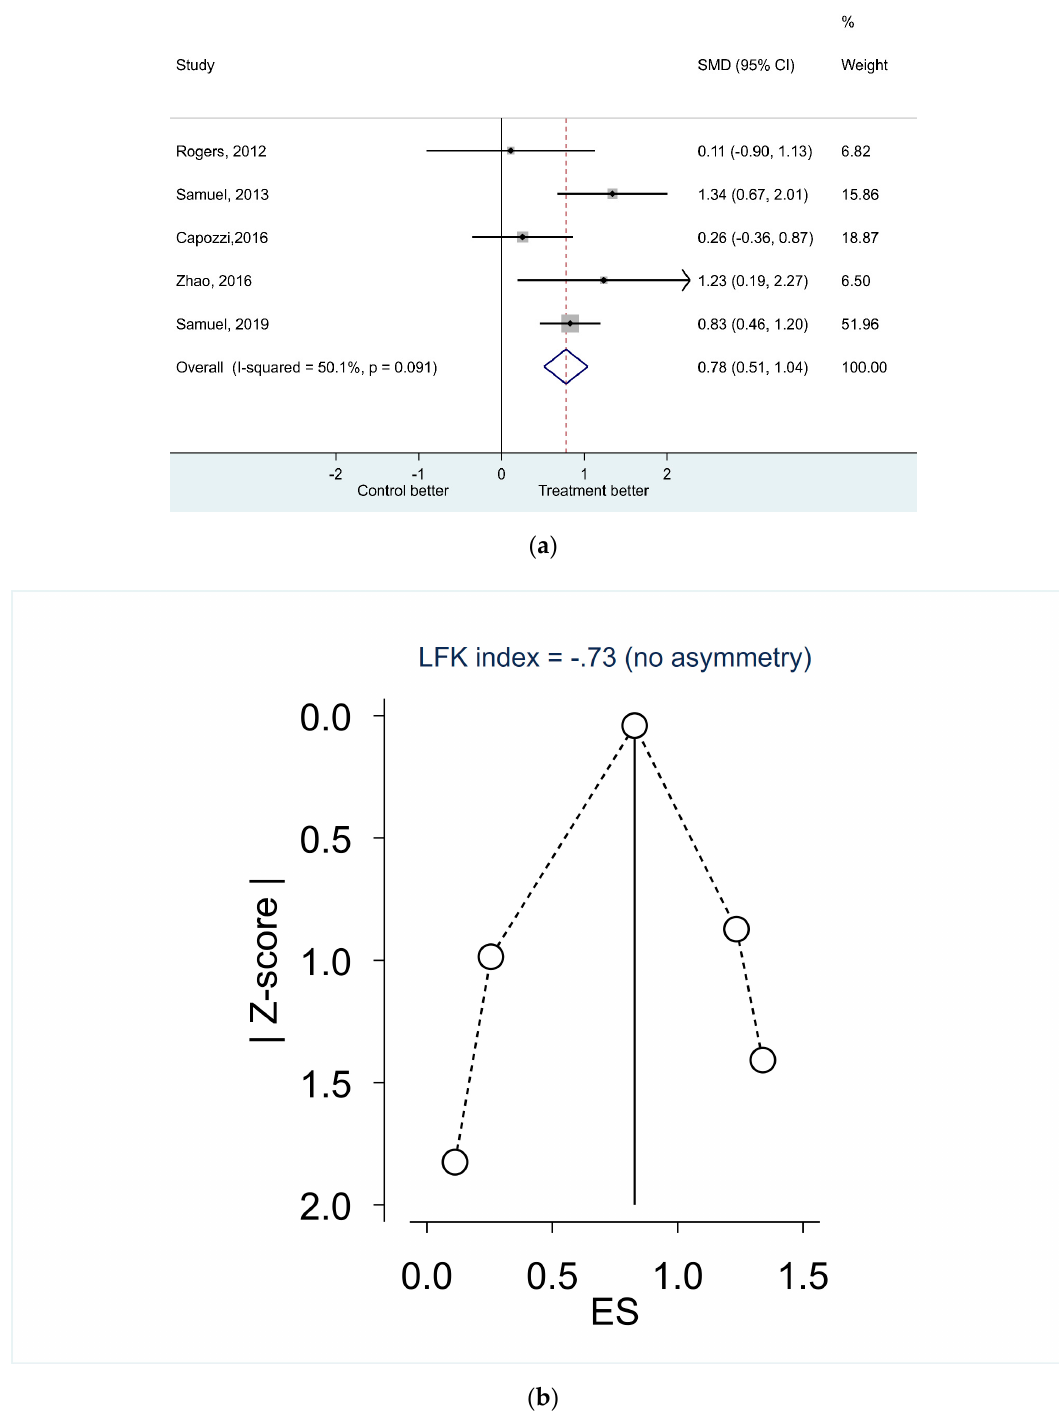
Figure 3. ( a )Effects of nutritional and exercise interventions on physical function; ( b ) the symmetry of physical function results presented in Doi plot.